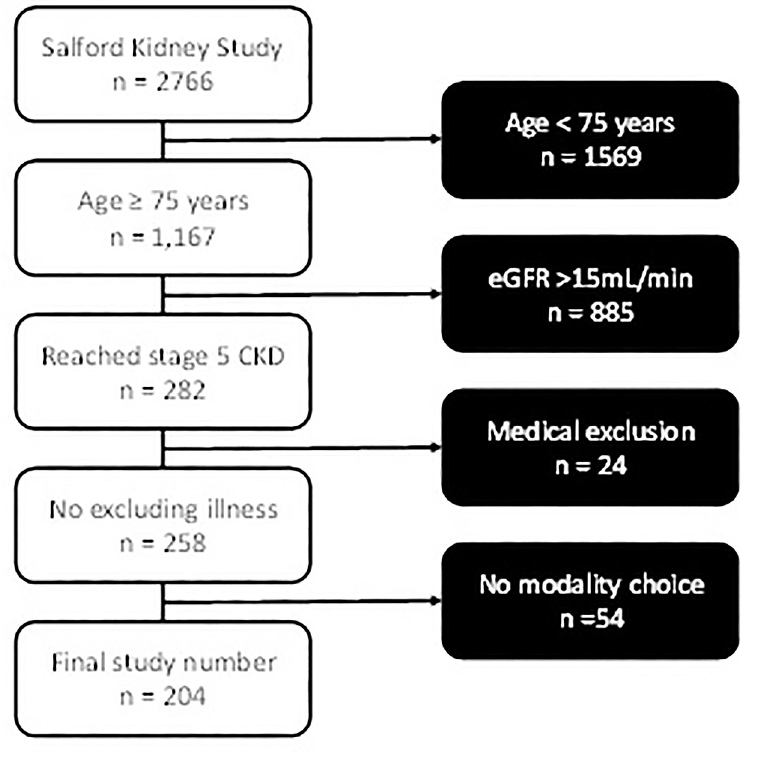
Fig 1. Reasons for exclusion from the